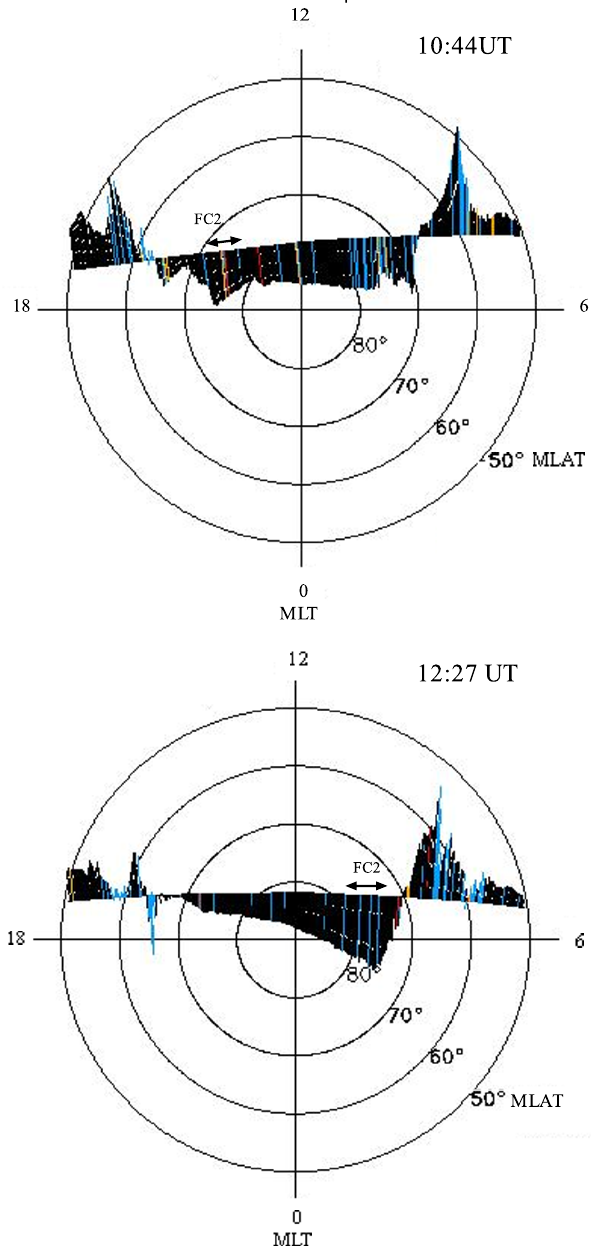
Fig. 9. Cross-track ion drifts along two consecutive satellite passes across the polar cap from dusk to dawn in the Northern Hemisphere centered at 10:44UT (top panel) and 12:27UT (bottom) obtained by satellite DMSP F13. The coordinate system is MLT/MLAT. Lat- itude circles at 50–80 ◦ MLAT have been drawn. The drift scale is shown in a later figure. (Blue and yellow mark “undetermined” and “caution”, respectively).